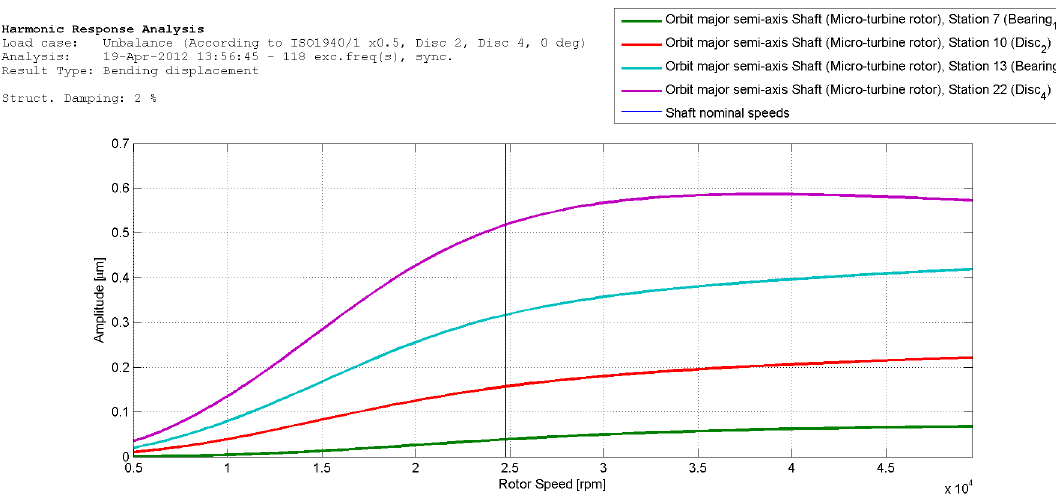
Figure 13: Amplitude of the rotor vibration for the unbalance of the discs No. 2 and No. 4 equal to 0.6 × 10 −6 kg ·